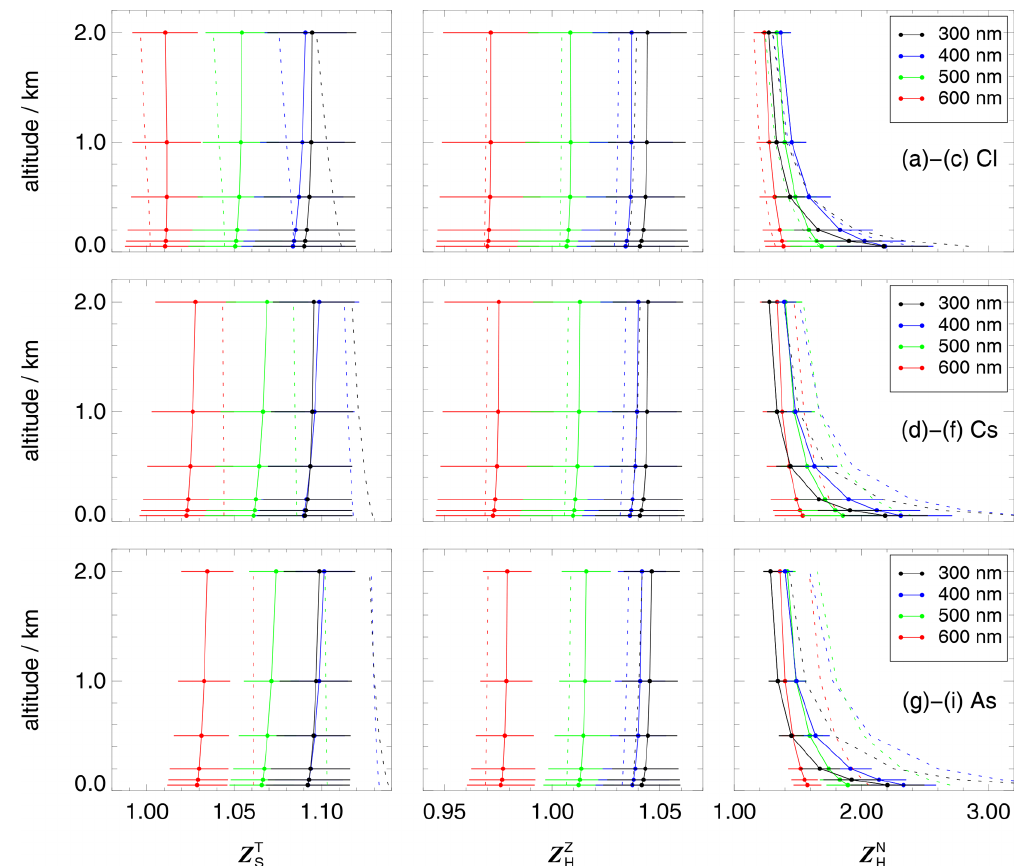
Figure 11. Altitude dependence of modelled Zeppelin correction functions Z T flux densities for a solar zenith angle of 40 ◦ and selected wavelengths. Corrections apply to standard aerosol load and ground albedos in different cloud cases. (a–c) Clear-sky (Cl), (d–f) Cs cloud layer and (g–i) As cloud layer. Error bars include the effects of ± 5 ◦ attitude variations. Dashed lines show results assuming hemispherical–isotropic distributions of downward and upward diffuse spectral